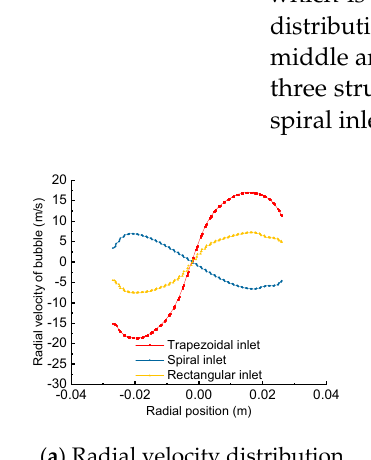
Radial position (m) Trapezoidal inlet Spiral inlet Rectangular inlet Figure 8. Static pressure distribution curve of section Z. The tangential velocity is the cause of the centrifugal force, so the tangential velocity can be used to measure the separation effect. The tangential velocity has two peaks in the pressure distribution cloud chart, which are caused by the composite vortex formed by the internal and external vortices. This is the Ranking vortex [30]. Figure 9 shows the trend lines of the three sub-velocities in section Z. These three sets of parameters can well reflect the changing law for the flow field in the separator and reflect the vortex motion in the flow field. After the mixed liquid was separated by the swirling flow inside, the process of moving the bubbles upward and out was realized by the parameter of radial velocity. It is apparent from the radial velocity distribution curve in the figure that its distribution was basically symmetrical; the radial movement speed of the trapezoidal inlet bubble was the fastest, and that of the rectangular inlet bubble was the slowest. This shows that the trapezoidal inlet had the strongest ability to flow toward